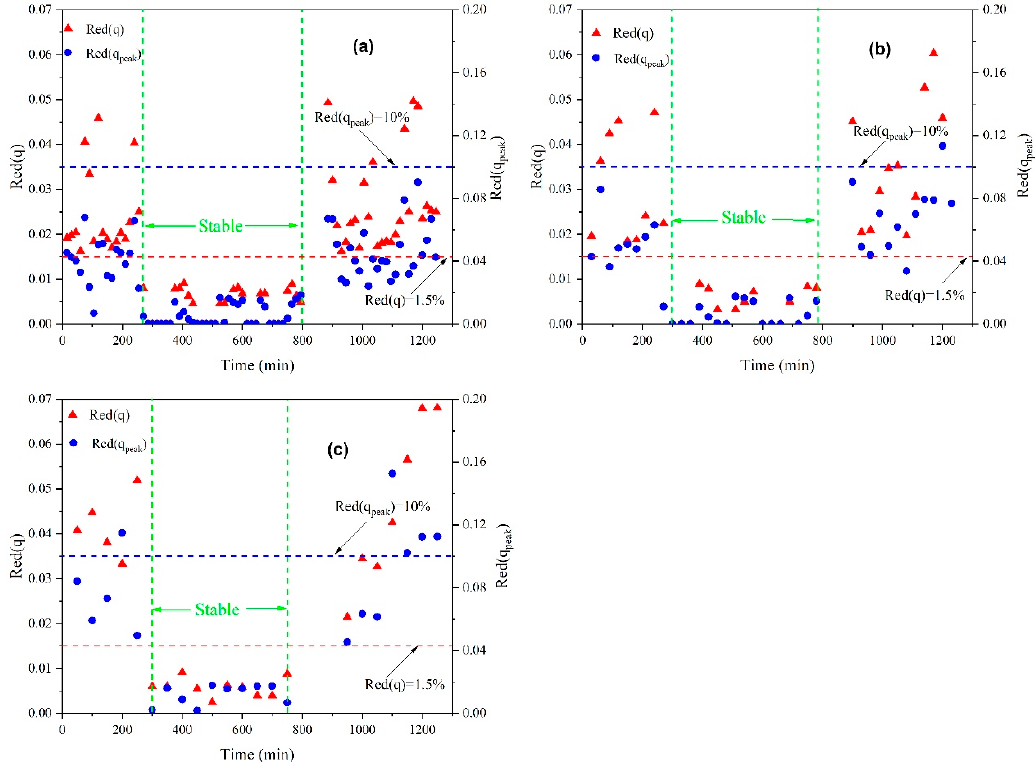
Figure 7. The determination of stable power input with different semi-superposition segmented time-sections of 30 min ( a ), 60 min ( b ), and 100 min ( c ).